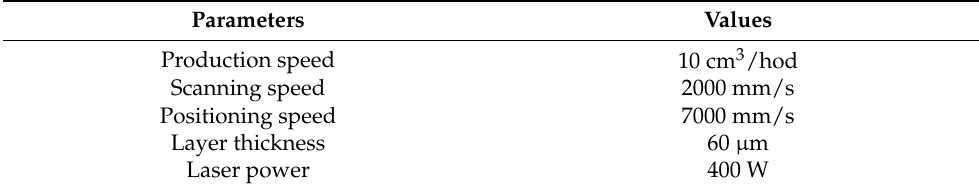
Table 2. Technological parameters for DMLS